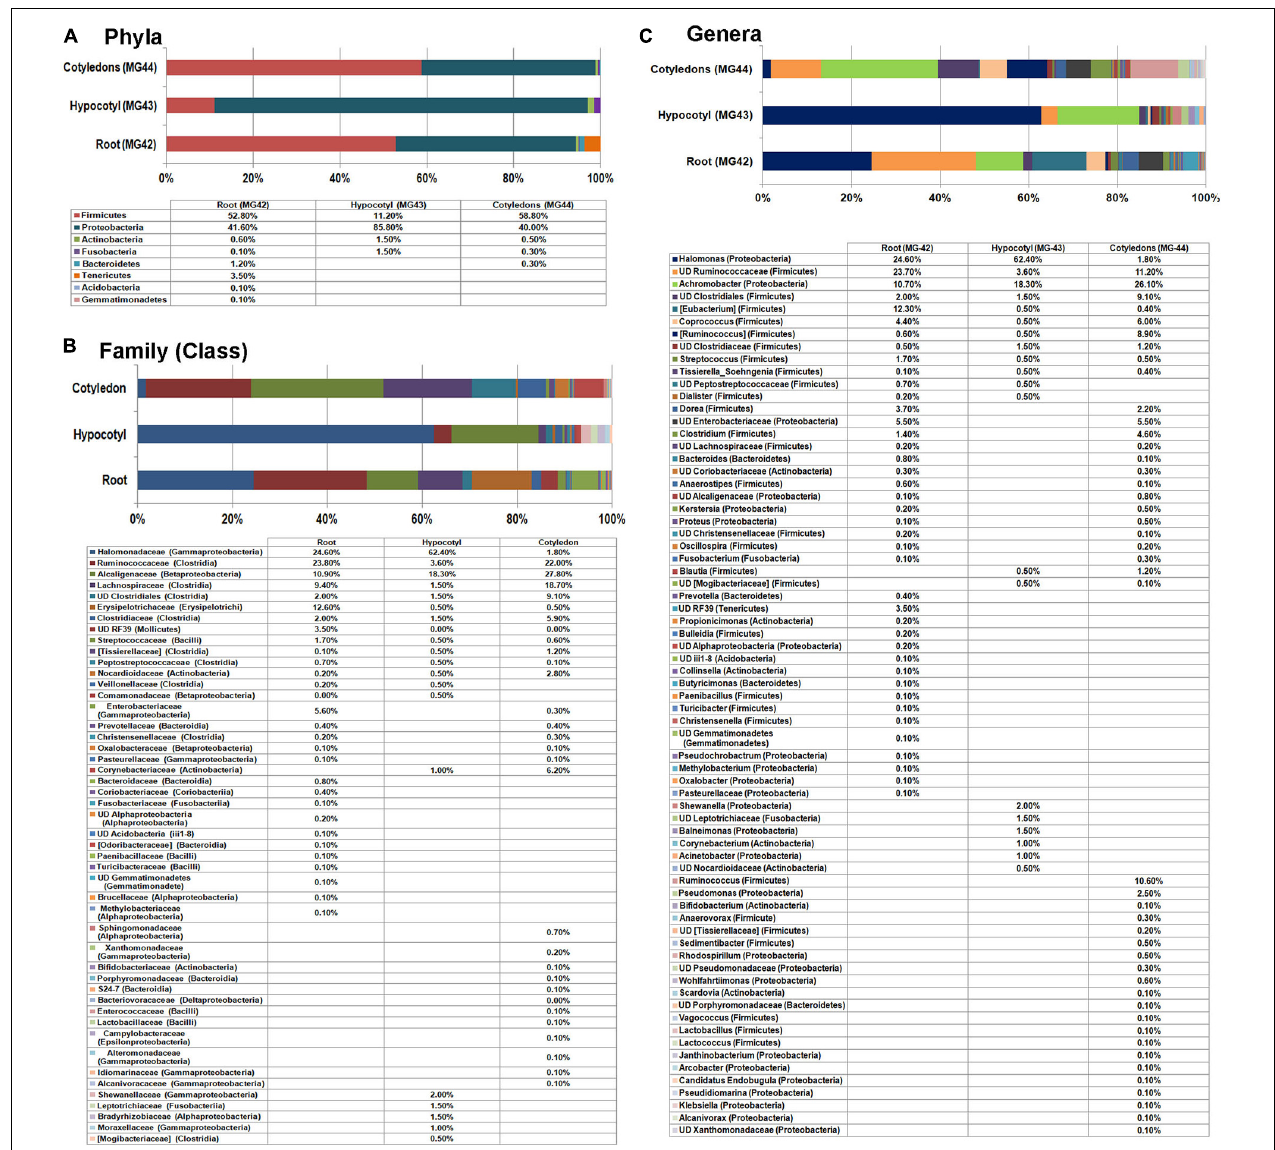
FIGURE 5 | Distribution of phylogenetic groups as per 16S rRNA metagene V3–V4 region taxonomic profiling of DNA derived from the root, hypocotyls, and cotyledon tissues of 2-week old in vitro grown seedlings of watermelon “Arka Manik” at phylum (A) , family (B) , and genus (C)